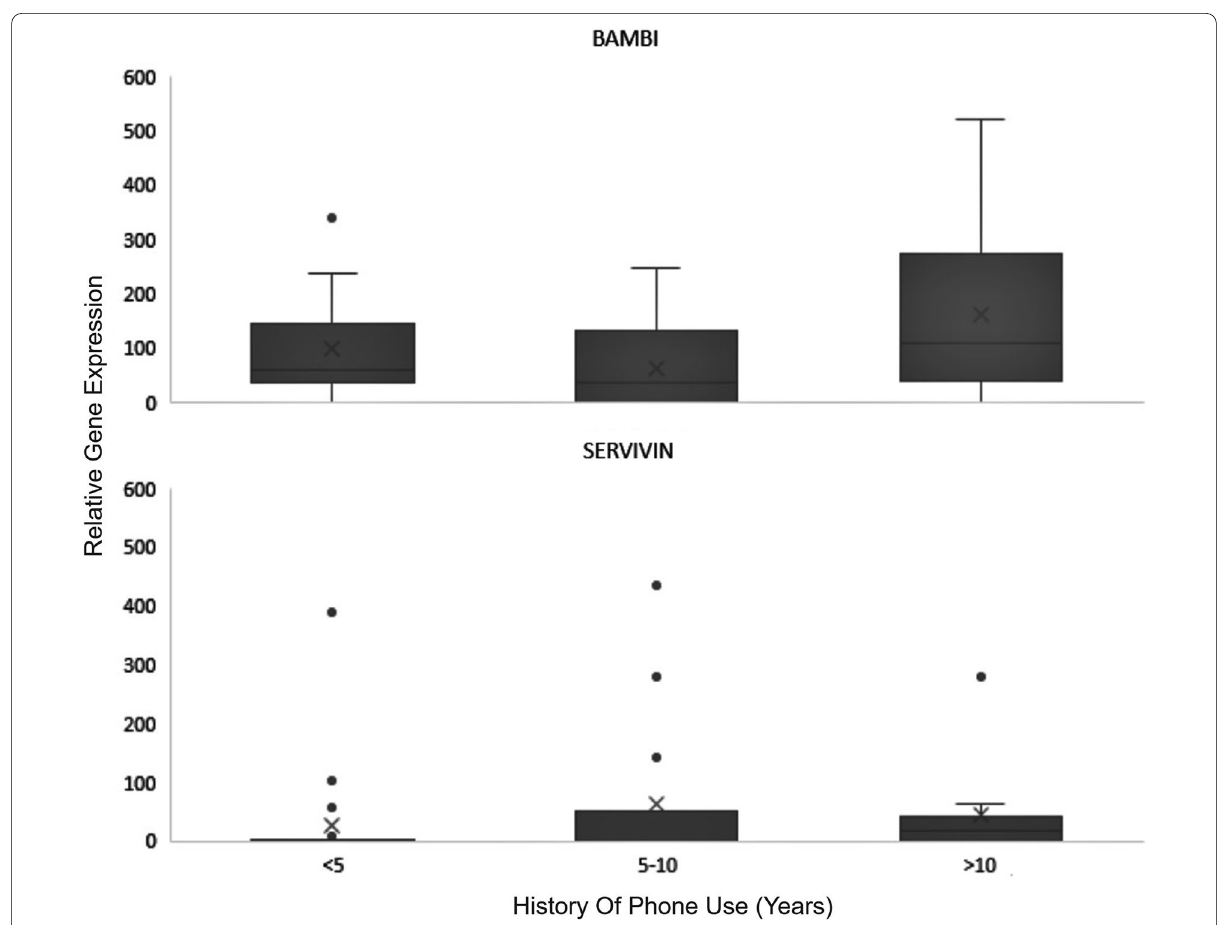
Fig. 4 Real‑time PCR analysis of the relative gene expression (2 − ΔΔ C T ) in the buccal cells of mobile users in relation to the history of phone use (Year). Data are reported as mean SE ratios of relative expression ±